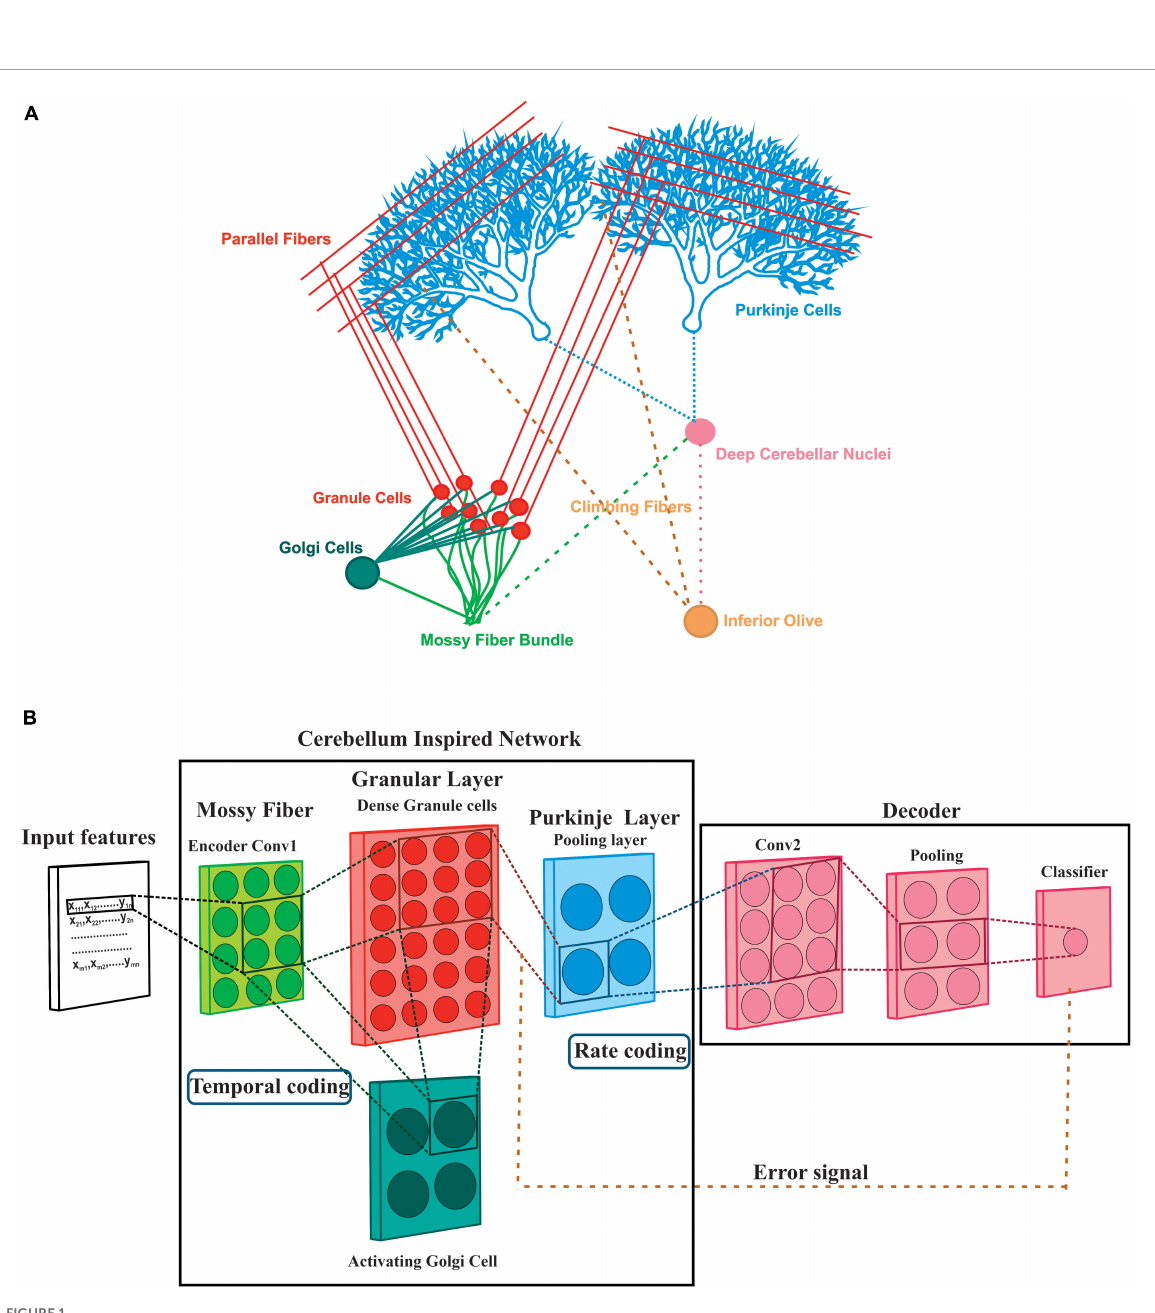
FIGURE1 A deep layer network of the cerebellum. (A) The abstracted model was based on the simplified cerebellar microcircuitry of rat cerebellum: Various neurons and connections in the cerebellar circuitry may attribute to pattern classification and prediction. Input patterns are presented through the Mossy fibers (MF) which have projections on the Granule cells (Grc) extended as Parallel fibers (PF) and Golgi cells (GoC). PF impinges onto the Purkinje cells (PC) which gives input to the output neuron Deep Cerebellar Nuclei (DCN) which in turn evokes Inferior Olive (IO). From a deep learner perspective, the cerebellum has been known to perform supervised learning with the teaching signals send to the PC through the IO extension Climbing fibers (CF). (B) The equivalent model of deep learning involved a spiking neural network: All the neurons inside the cerebellum-inspired network were reconstructed as spiking models whereas the decoder was modeled with nodes. Each instance was mapped to a convolution layer that encodes to a group of MF. Convoluted cells mapped to a dense granular layer (Diwakar et al., 2011) representing the sparseness of the MF stimuli which is also activated by an inhibitory GoC model. Rate coding of the inputs, convolution at the GrC layer, and SoftMax based output prediction post the pooled layer was implemented at the MF-GrC-PC